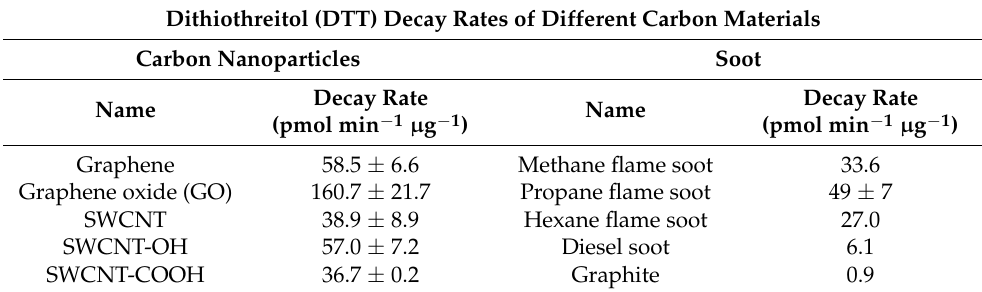
Table 8. Dithiothreitol (DTT) decay rates of different carbon materials. Data adapted from [141].